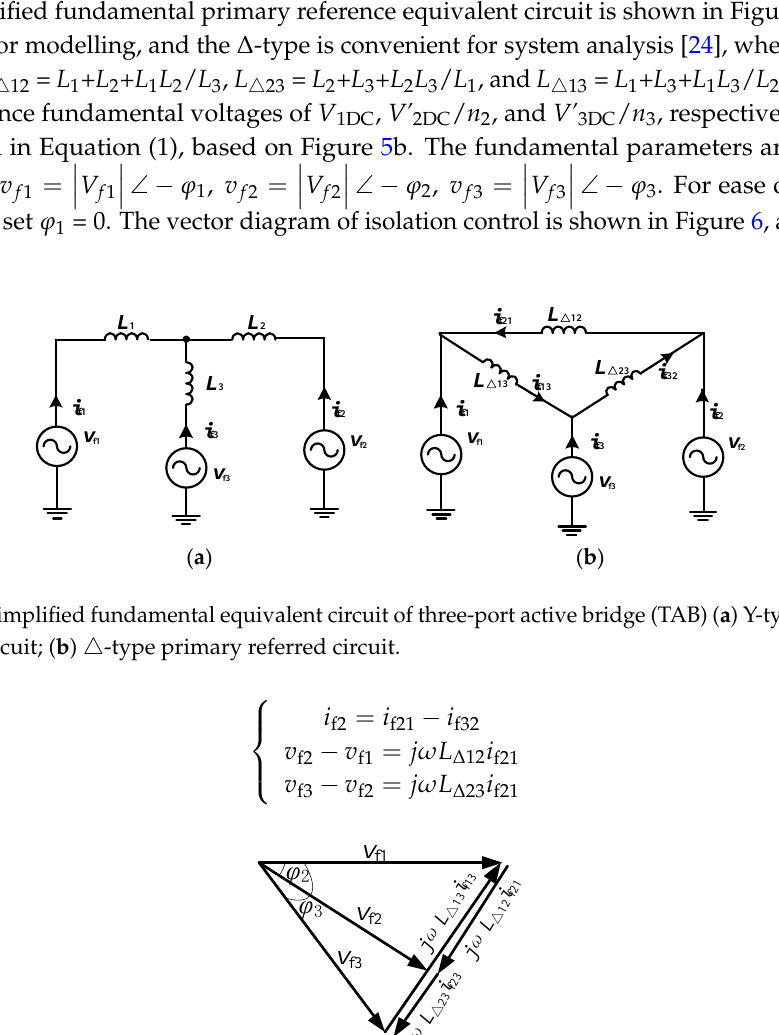
Figure 6. Vector diagrams for the charging mode.